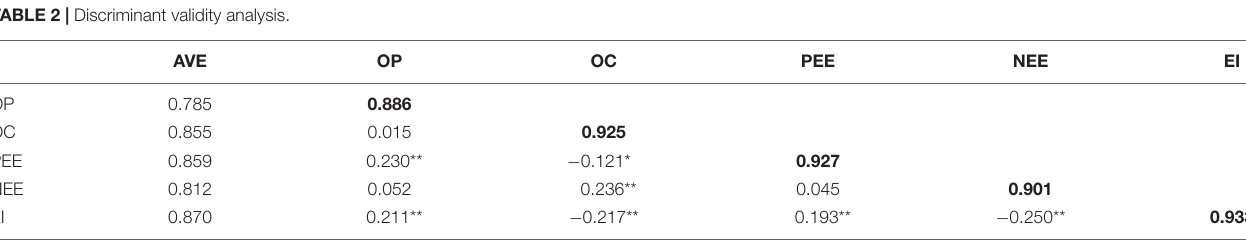
TABLE 2 | Discriminant validity analysis.